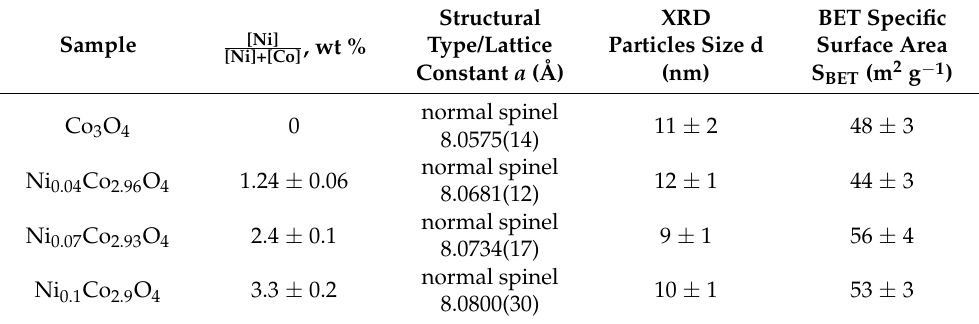
Table 1. Composition and microstructure parameters of Co 3 O 4 and Ni x Co 3 − x O 4 samples.